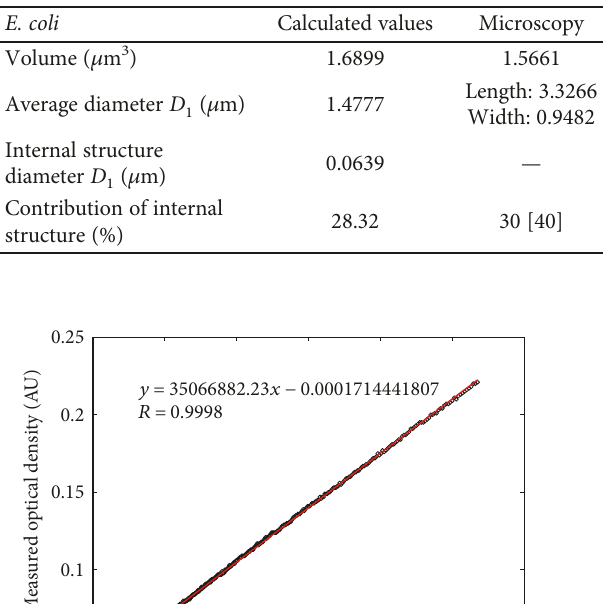
Figure 4: The decomposition of E. coli spectral data: scattering and absorption